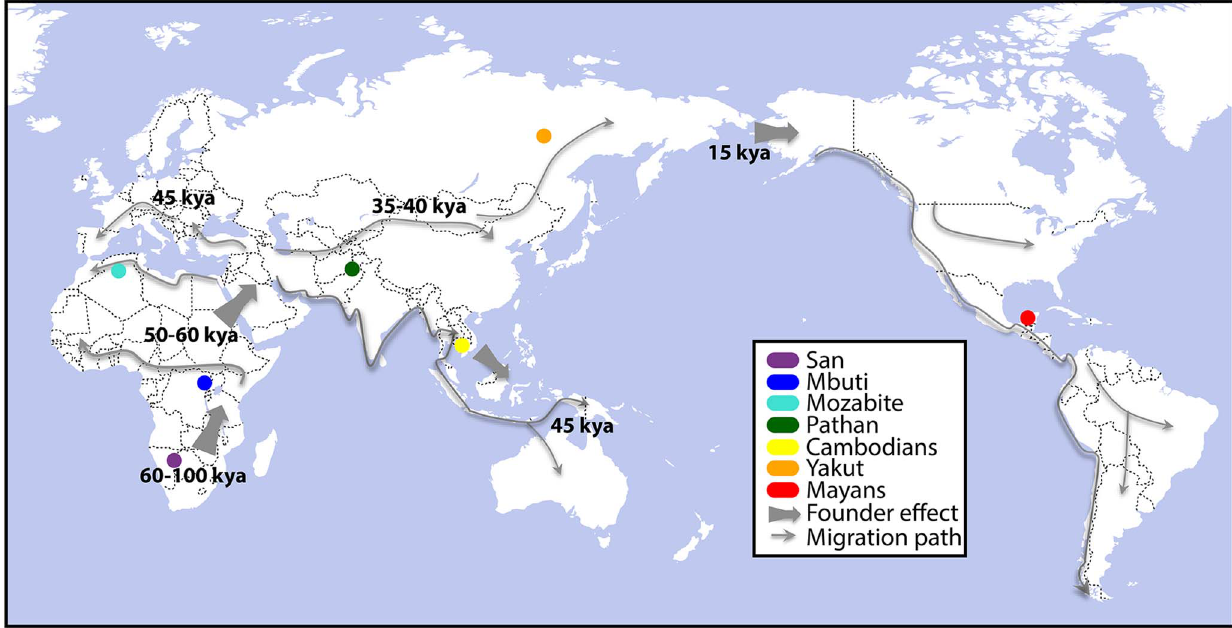
Figure 1. Collection sites for genome-, exome-, and RNA-sequenced human lymphoblastoid cell lines (LCLs). LCLs were immortalized from the populations highlighted above, as described previously [21], and the genomes, exomes, and transcriptomes were sequenced. Founder effect and migration paths have been reproduced from [53] to highlight the breadth of human migration history across which these LCLs were sampled.